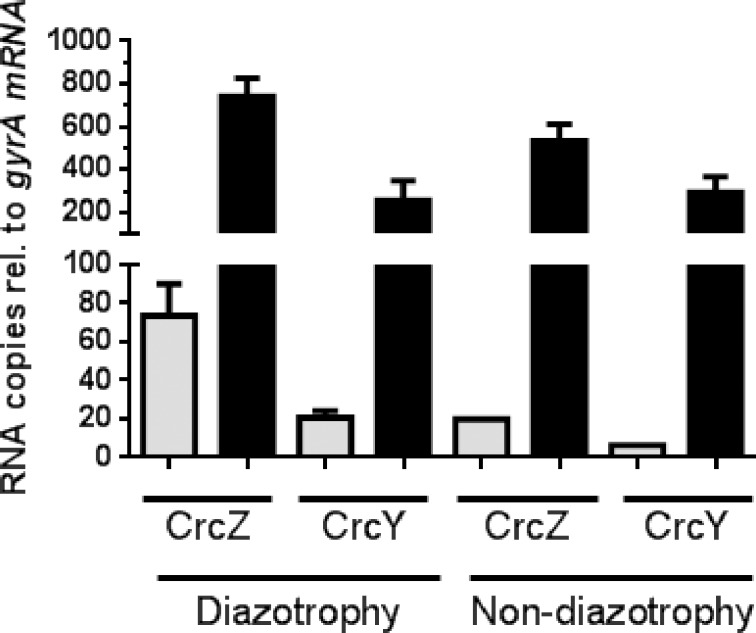
Quantification of the CrcZ and CrcY levels.Relative levels of the CrcZ and CrcY sRNAs, measured by qRT-PCR in cells of the A. vinelandii AEIV strain growing exponentially at the expense of acetate (gray bars) or glucose (black bars) in BAG medium in the absence (diazotrophy) or presence (non-diazotrophy) of 15 mM NH4Cl. The values are expressed as RNA copies relative to those of gyrA mRNA (internal standard).